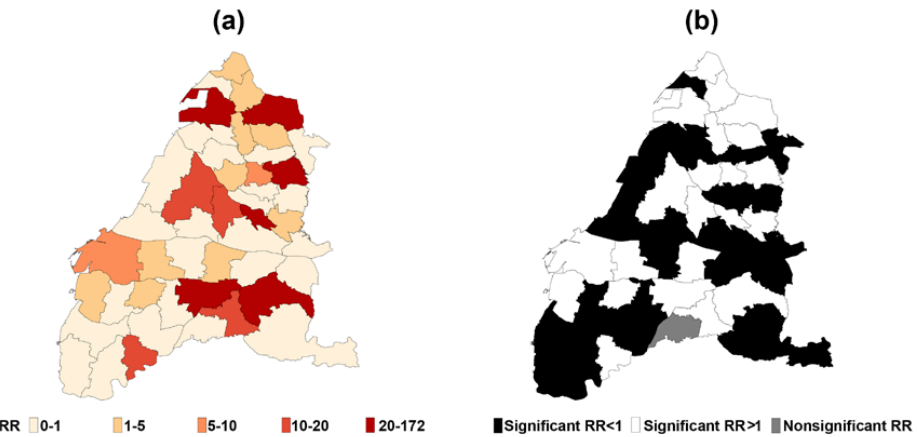
Figure 6. Maps for each district in Changhua County and Yunlin County according to the transformed estimated spatial function. Map ( a ) is the relative risk (RR) of children’s asthma from small (white) to large (red). Map ( b ) is the statistical significance of RR in each district determined by the 95% confidence interval, where black represents a significant RR < 1, white represents a significant RR > 1, and gray represents a nonsignificant RR.